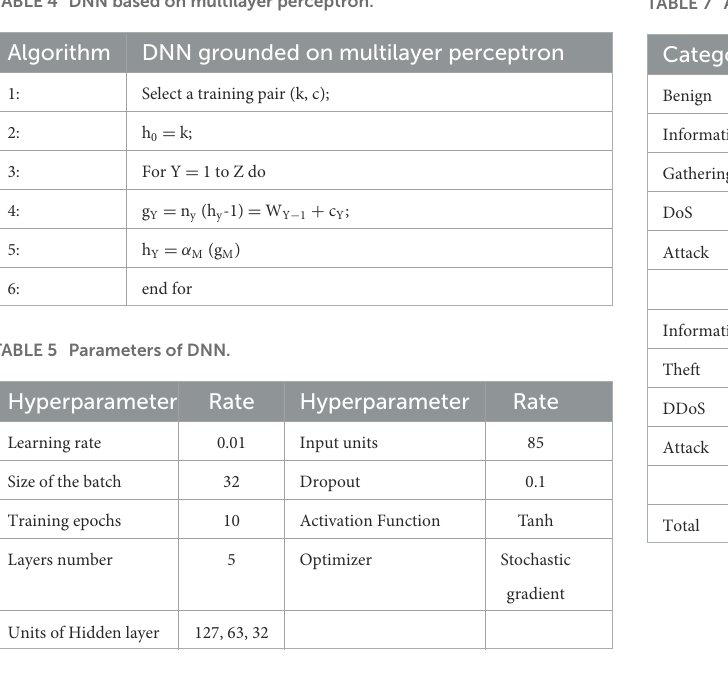
TABLE 4 DNN based on multilayer perceptron.